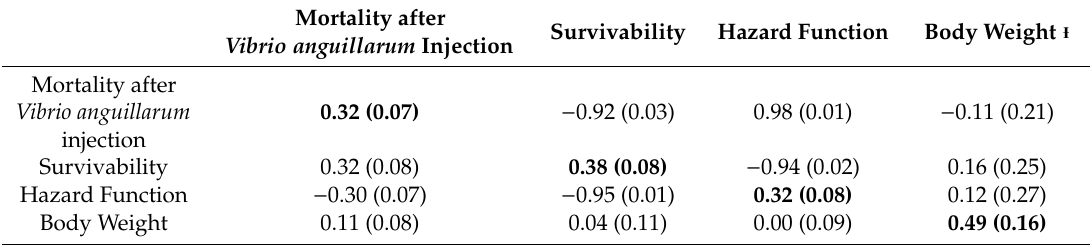
Table 3. Estimates of heritability (bold), genetic correlation, and phenotypic correlation (above and below the diagonal, respectively). Standard errors are in parenthesis. Table 4. Estimates of heritability (bold), genetic correlation, and phenotypic correlation (above and below the diagonal, respectively).